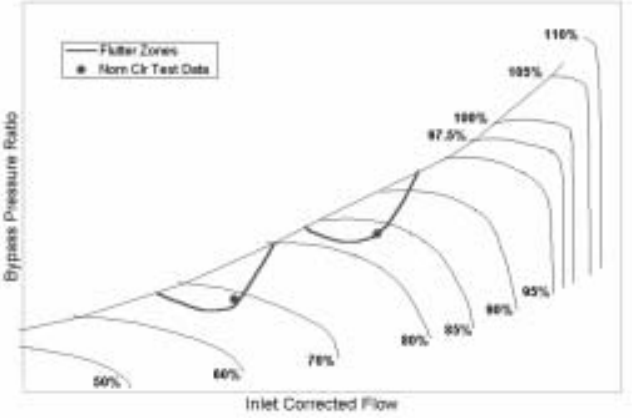
Fig. 2. Performance map showing the flutter boundaries of the unshrouded fan.